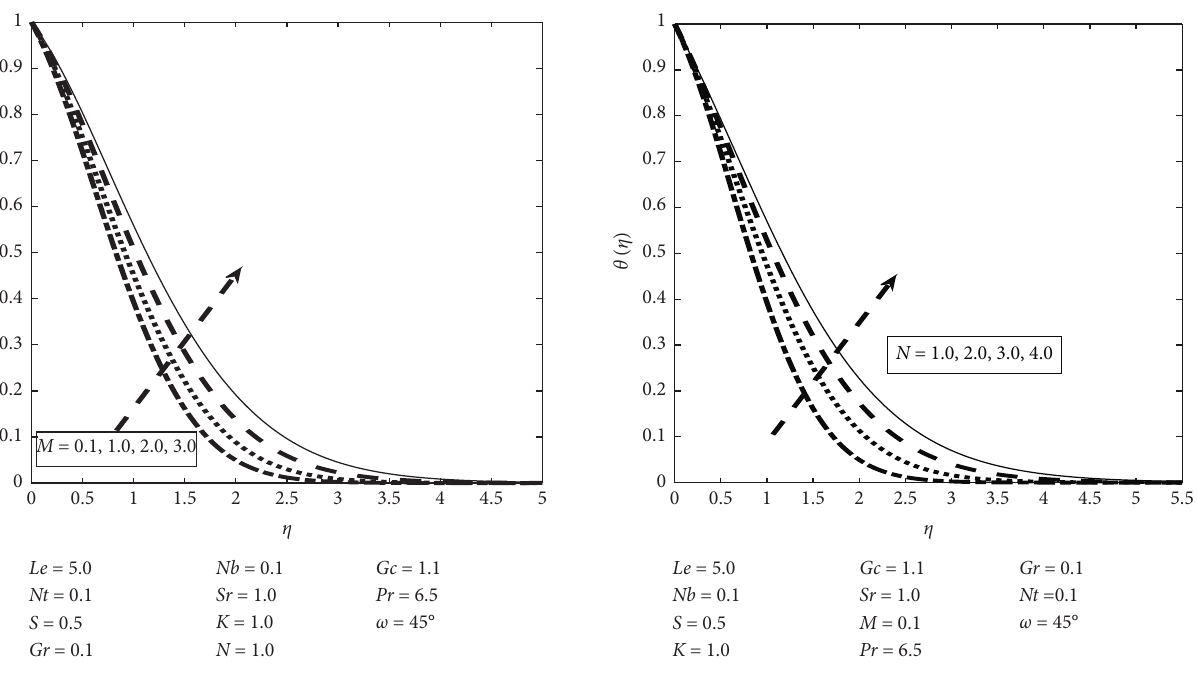
Figure 11: Temperature profile for several values of N .